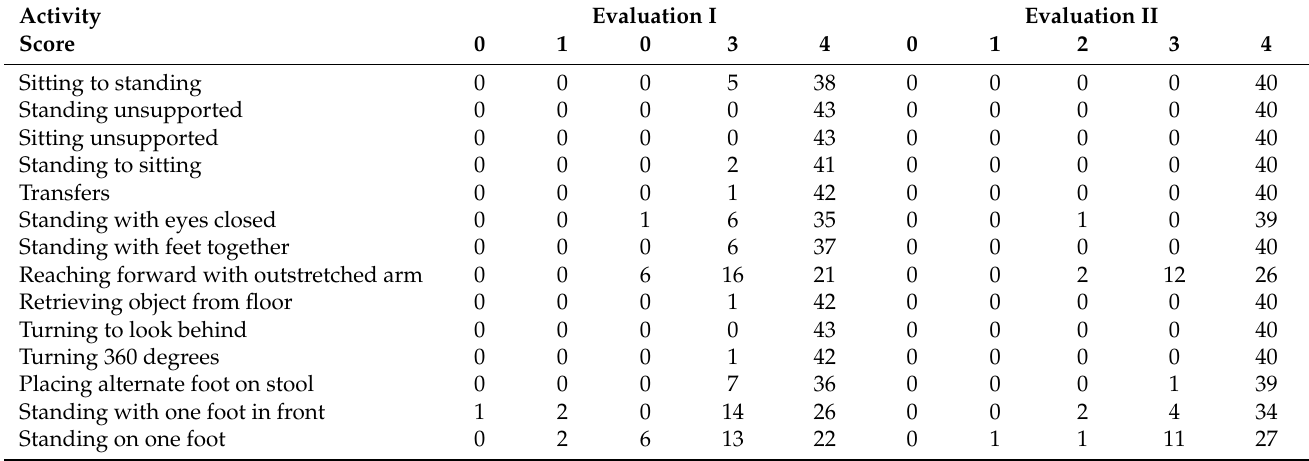
Table A2. Scores on the Berg Balance Scale in 43 patients at the first evaluation and 40 patients at the second